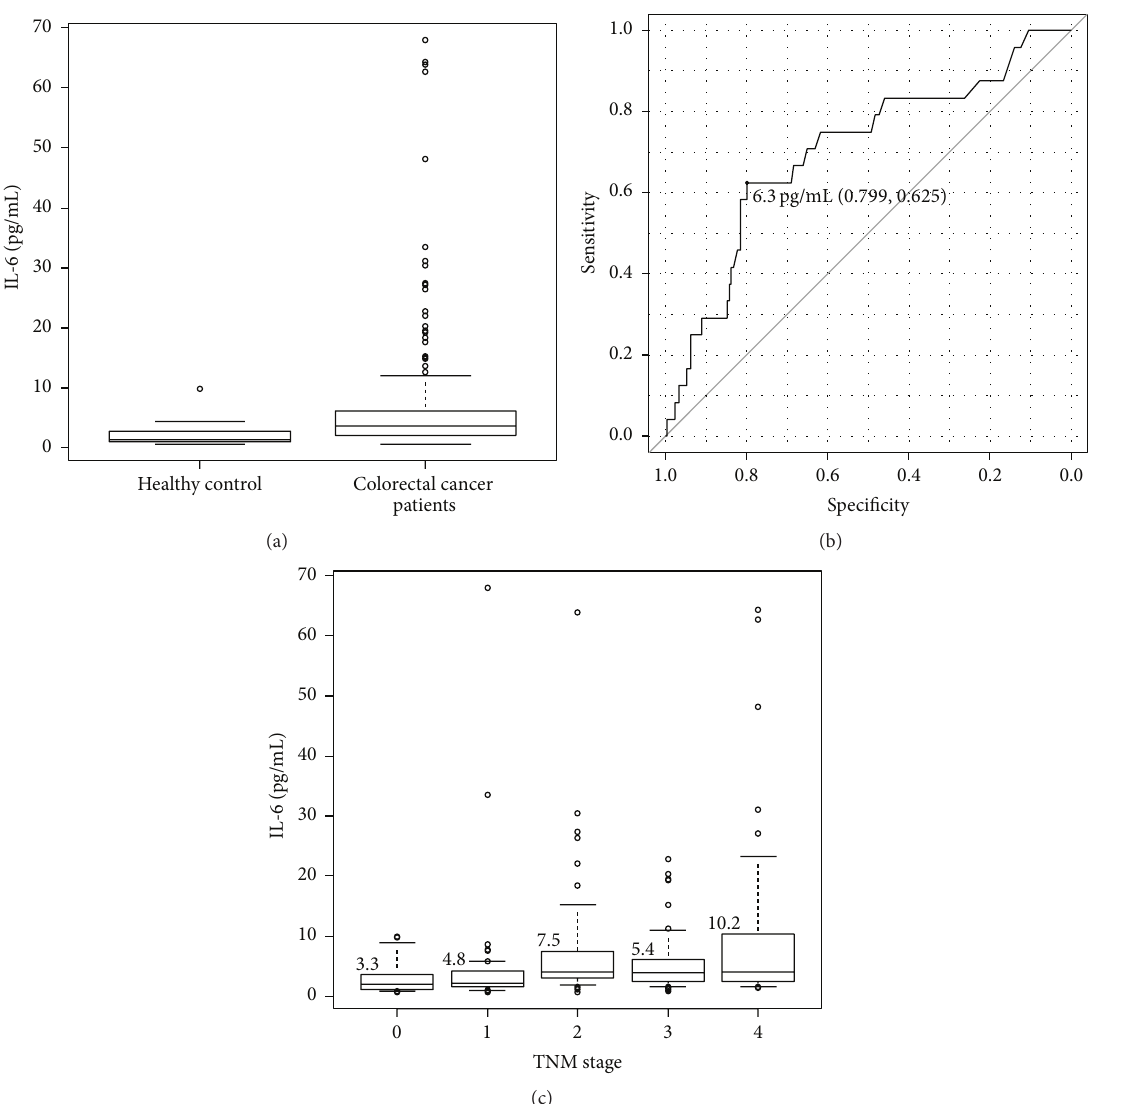
Figure 1: Measured serum interleukin-6 (IL-6) values. (a) Preoperative serum IL-6 values for all patients ( 𝑛 = 233 ). The mean value was 6.6 pg/mL (range: 0.7–68.0). (b) Receiver operating characteristic curve of IL-6 according to survival. The optimal cutoff was determined as 6.3 pg/mL. (c) IL-6 values according to the disease stage. Mean values: stage I: 4.8 pg/mL, stage II: 7.5 pg/mL, stage III: 5.4 pg/mL, and stage IV: 10.2